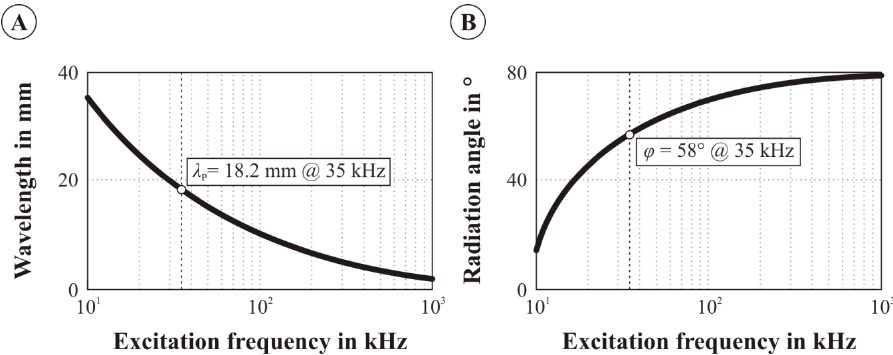
Figure 3. Determination of the radiation angle. ( A ) Wavelength of the A 0 ‐ mode in a 2 mm thick GF/PA6 plate; ( B ) Radiation angle of sound waves in air.